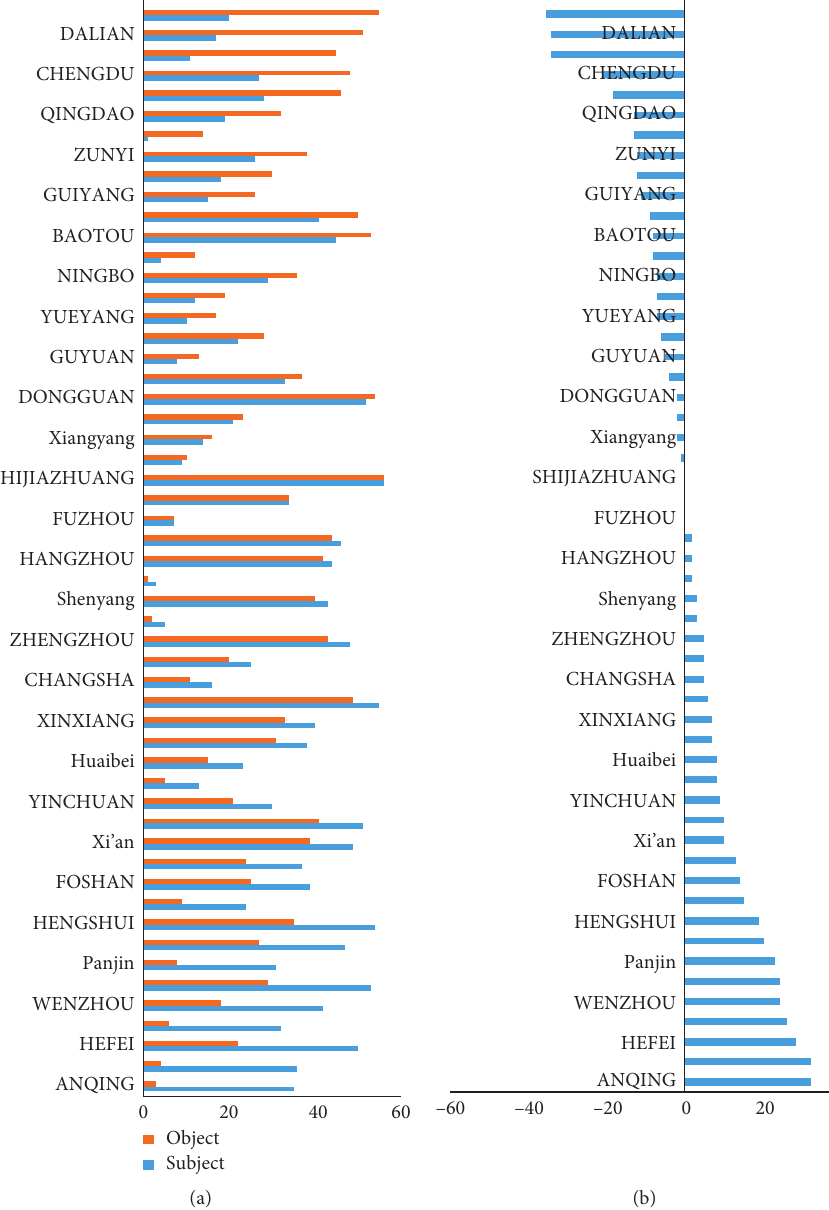
Figure 2: The subjective ranking and objective ranking and difference of environmental quality in each